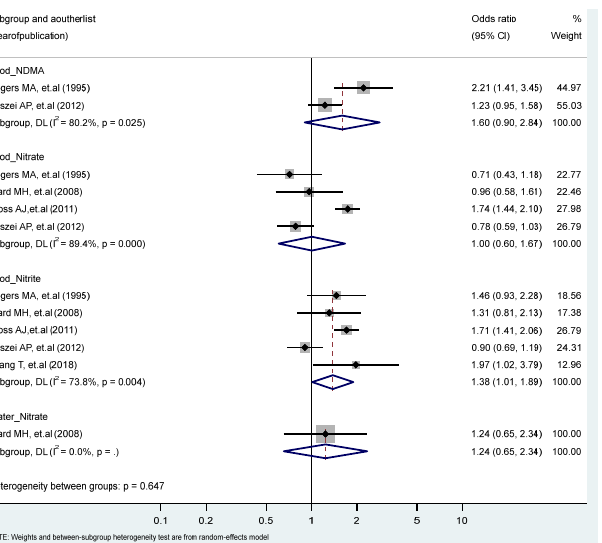
Figure 2. Forest plot (random ‐ effects model) quantifying the relationships between NDMA, nitrite, and nitrate intake and esophagus cancer risk stratified by sources. List of references includes: